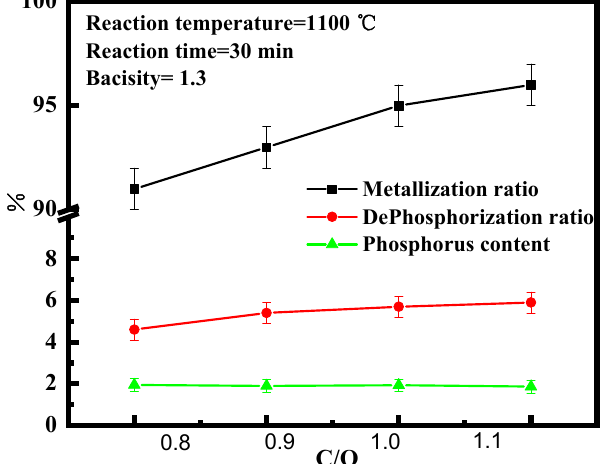
Figure 4. The effects of the C/O ratio on the metallization ratio, dephosphorization ratio, and phosphorus content of iron bead.